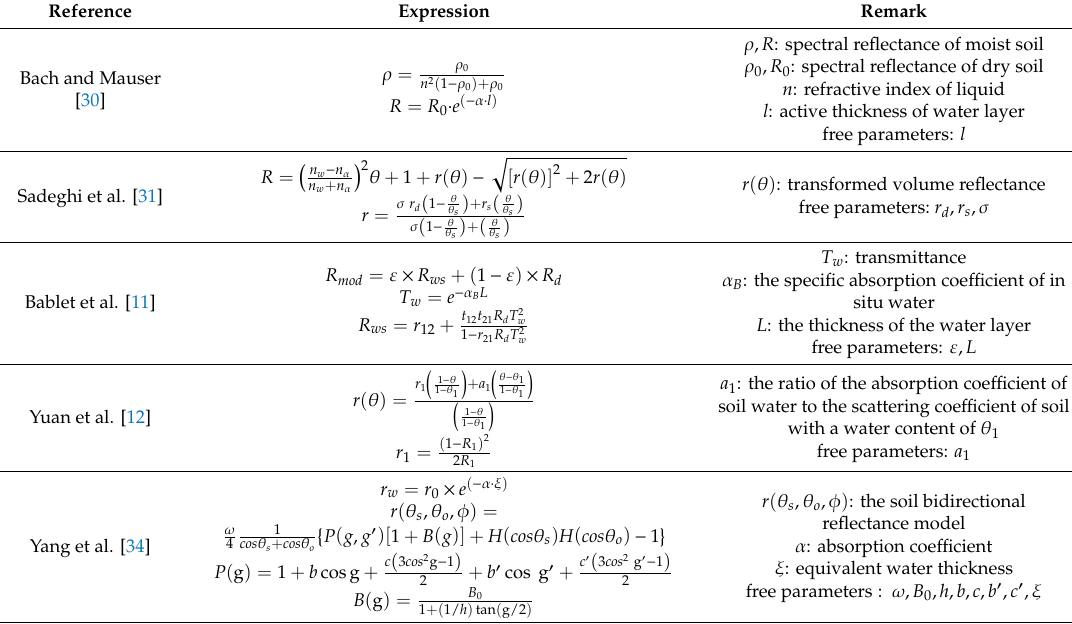
Table 1. Summary of the SMC retrieval models based on physical